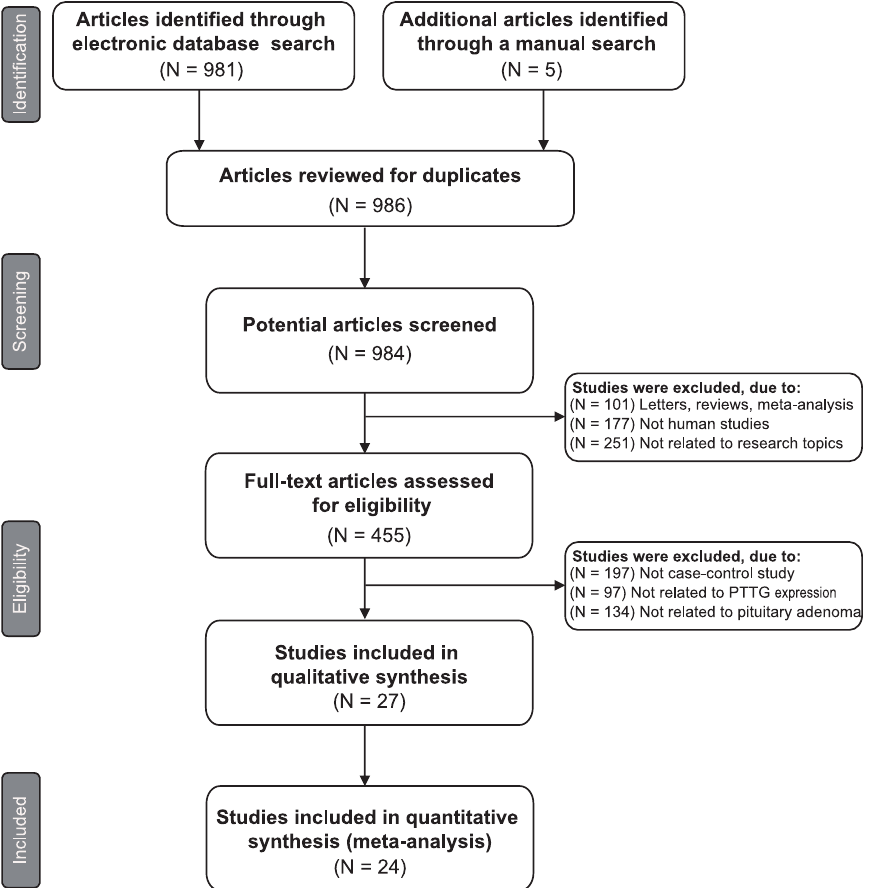
Figure 1. Flow chart shows study selection procedure. Twenty cohort studies were included in this meta-analysis.